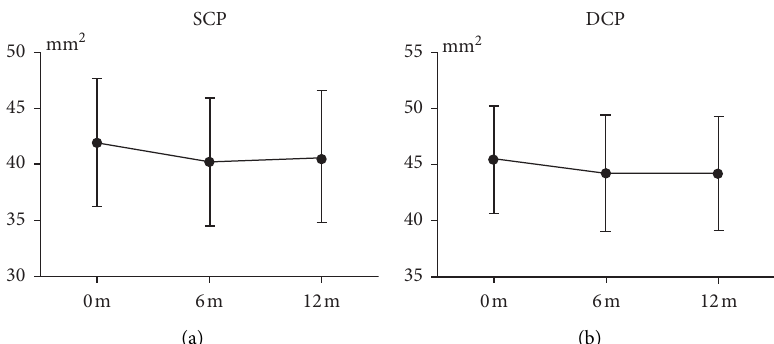
Figure 2: Changes in macular vascular density of the SCP and DCP within 12 months. SCP, superficial retinal capillary plexus; DCP, deep retinal capillary plexus. Table 4: Correlations between BCVA, CRT, intraocular pressure, SBP, DBP, and indexes of macular vascular density at baseline.